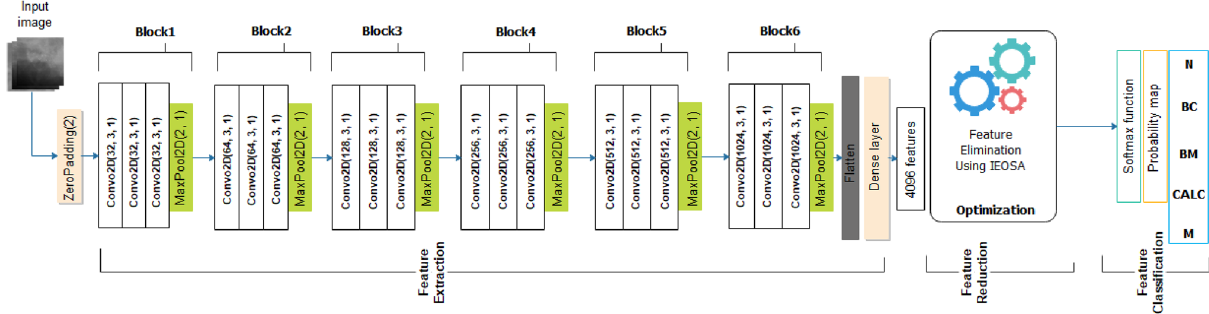
Figure 3. An illustration of the design of the CNN-IEOSA model consisting of the feature extraction, feature reduction and feature classification compartments. The CNN has six (6) convolutional-pooling blocks that output extracted features using a dense